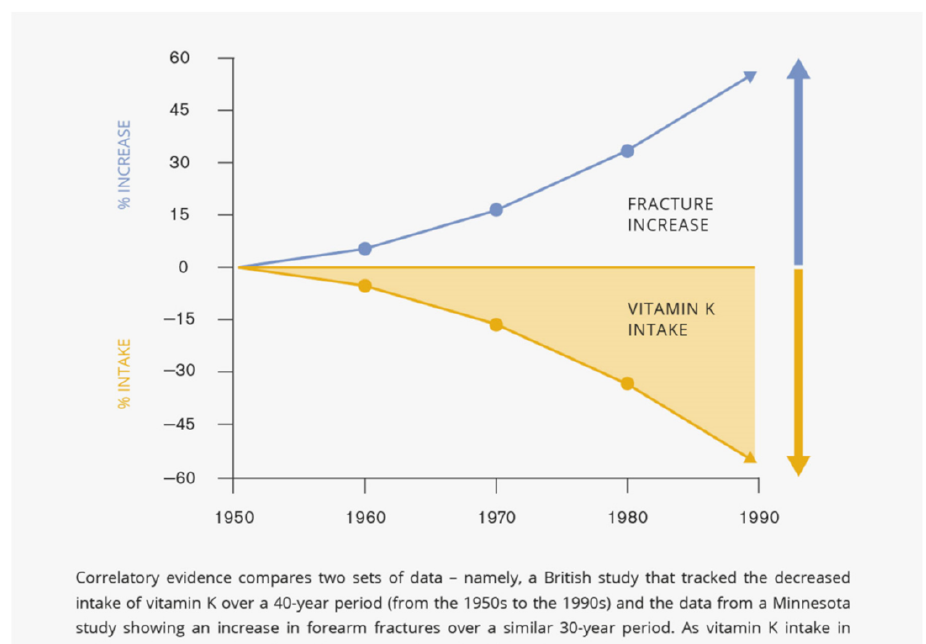
Figure 2. Low vitamin K intake corresponds with increased fracture